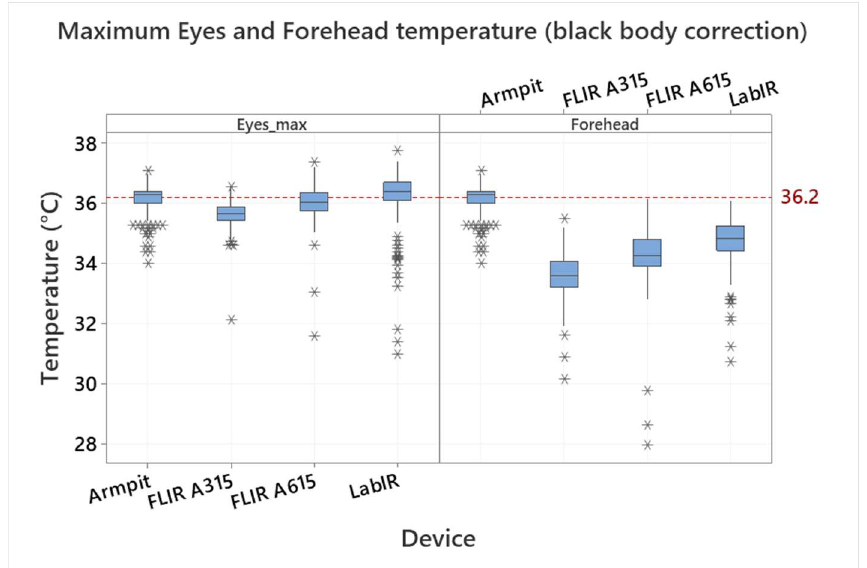
Figure 4. Comparison of eyes maximum (inner canthus) and forehead temperature measured by the FLIR A315, FLIR A615 and LabIR cameras (blackbody correction applied) with the body temperature measured by the armpit thermometer. Outliers are identified by asterisks (*).